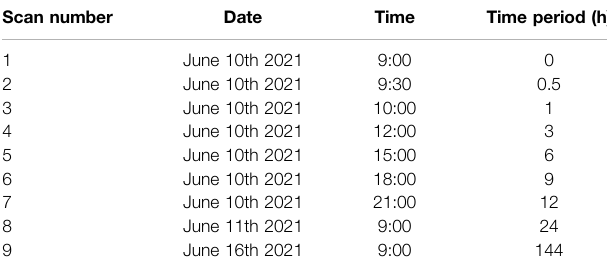
TABLE 2 | Date and time of the measurements made on plot G4N to assess the reliability of the MLS